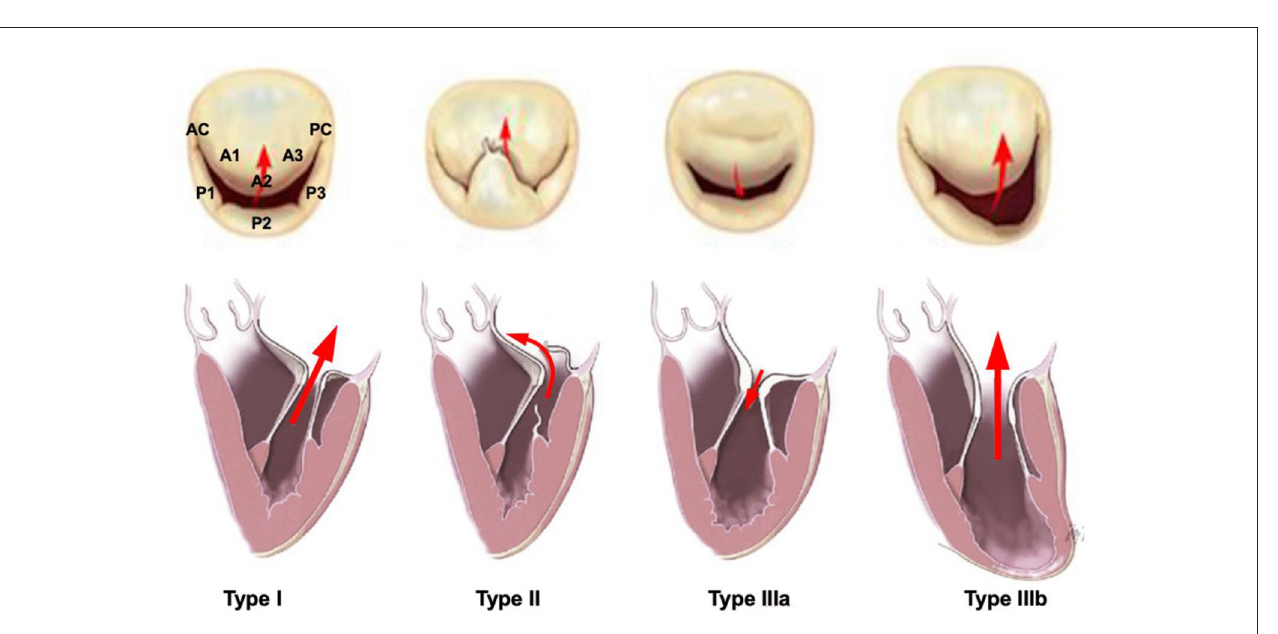
FIGURE 2 | Carpentier classification for mitral valve